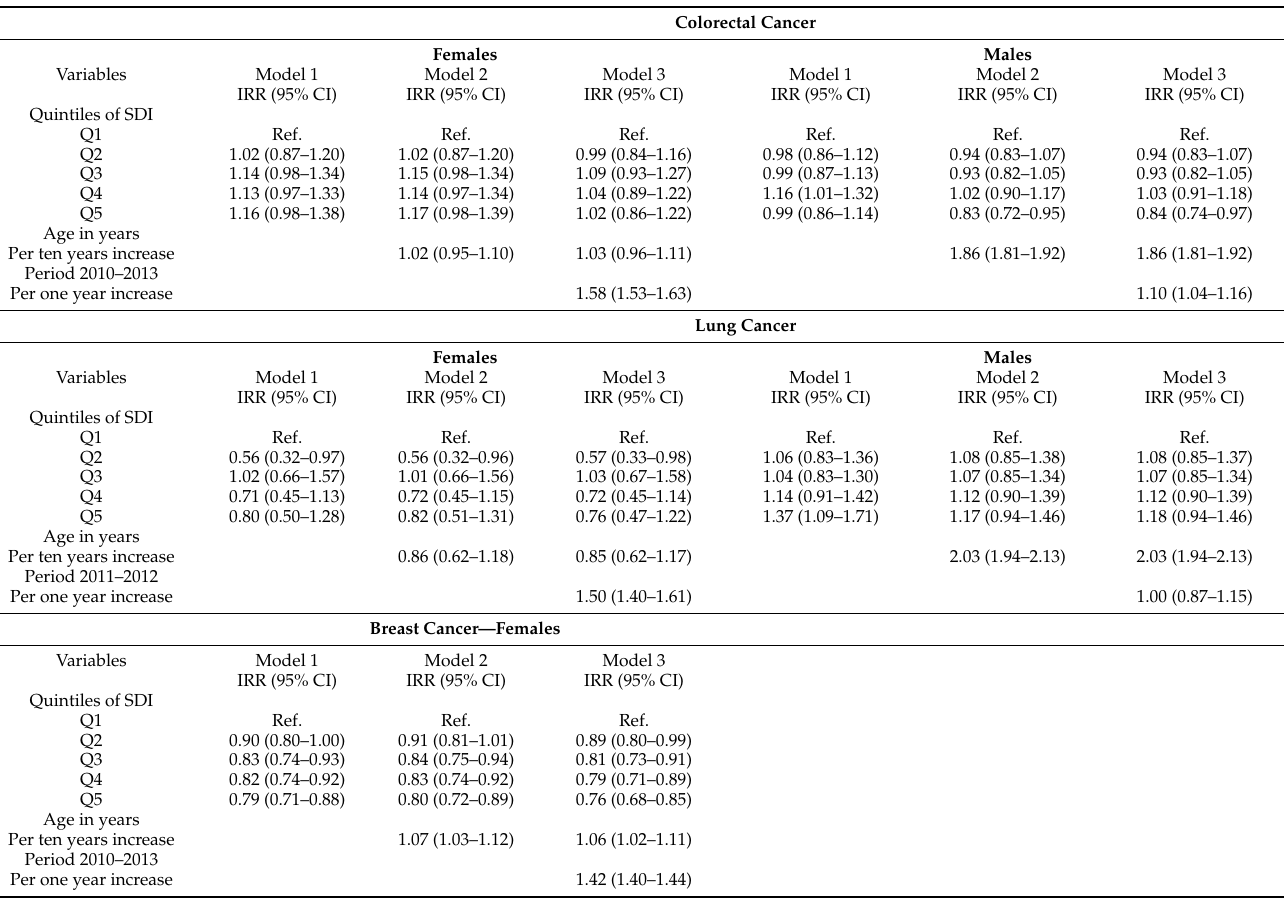
Table 2. Cancer incidence rates ratios by sex, adjusted for deprivation and age in Spain for the period